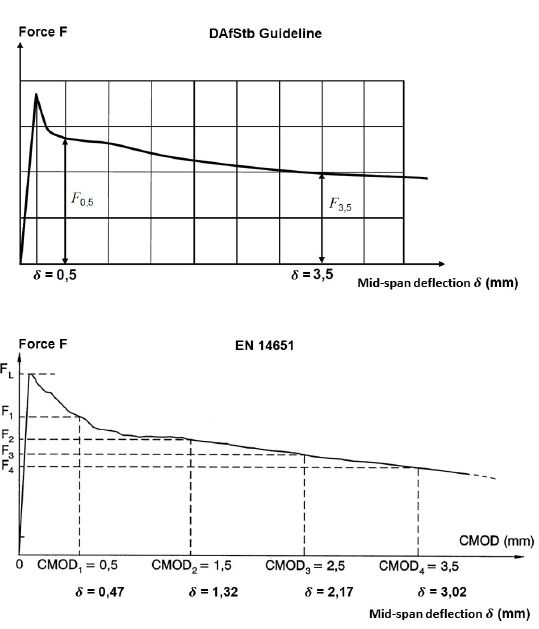
Figure 2. Evaluation of post-peak flexural strengths at different points. Up DAfStb-Guideline "Stahlfaser- beton", down EN 14651